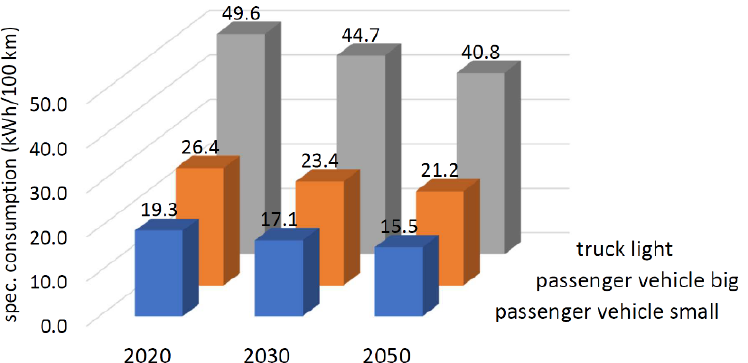
Figure 11. Specific consumption of BEVs until 2050.